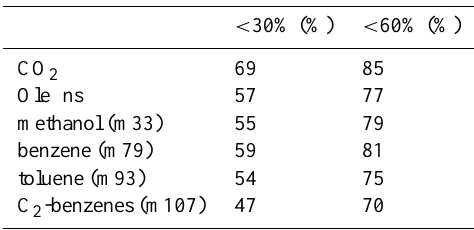
Table 3. Percent of periods that met the stationarity conditions for each one of the measured species. If the difference between the 30- min flux and the average flux of 6 continuous subperiods of 5min from that same period of 30min is less than 30%, the data is con- sidered of high quality, and between 30 and 60%, the data have an acceptable